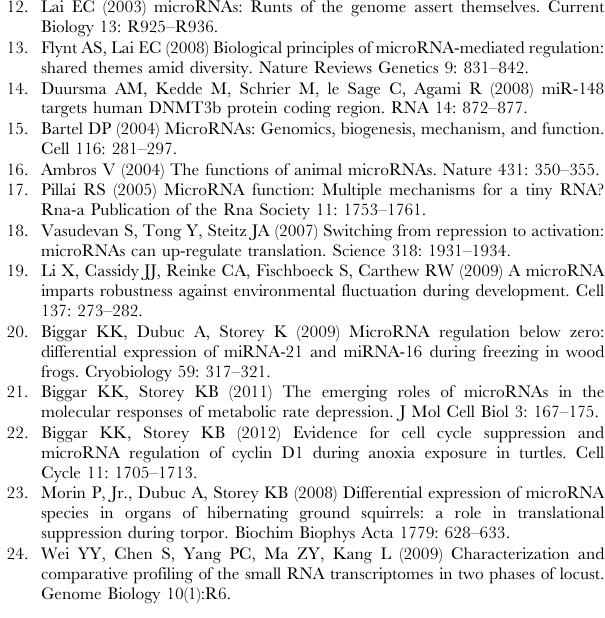
Figure S6 Effect of miR-133 overexpression or silencing on miR-133 expression. (A) miR-133 expression was quantified using qRT-PCR 24 h after the gregarious locust brains were treated with 42 pmol of agomir-133. (B) miR-133 expression was quantified using qRT-PCR 24 h after the solitary locust brains were treated with 42 pmol of antagomir-133. The data are shown as the mean 6 SEM ( n = 6) of one representative experiment. Figure S7 Effect of miR-133 overexpression or silencing on the expression of other miRNAs. The expression levels of other miRNAs (miR-7 and miR-252) were quantified using qPCR 48 h after the gregarious (G) and solitary (S) locust brains were treated with 42 pmol of agomir and antagomir-133, respectively. All data are shown as the mean 6 SEM ( n = 6) of one representative experiment. Figure S8 Effect of miR-133 overexpression or silencing on the expression of henna . (A) Henna expression was quantified using qRT-PCR 24 or 48 h after treatment of gregarious locust brains with 14 or 42 pmol agomir-133. (B) Henna expression was quantified using qRT-PCR 24 or 48 h after treatment of solitary locust brains with 14 or 42 pmol antagomir-133. The data are shown as the mean 6 SEM ( n =6) of one representative experiment. * p , 0.05; ** p , 0.01. Figure S9 miR-133 fosters the phase transition phenotype of the migratory locust. (A) The effects of 42 pmol of agomir-133 on the behavior of the gregarious locusts were studied 24 h after injection. (B) The effects of 42 pmol of antagomir-133 on the behavior of the solitary locusts were studied 24 after injection. P greg , probabilistic metric of gregariousness. The vertical lines indicate the median P greg values. Figure S10 Model of the miR-133-mediated dopamine pathway associated with the phase changes of the migratory locust. miR-